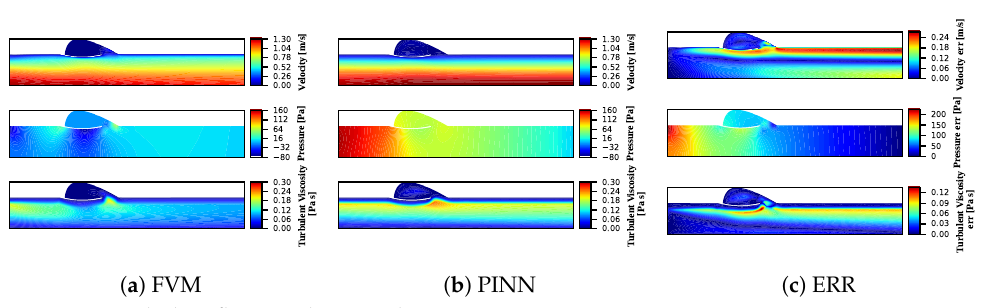
Figure A6. Turbulent flow: 75 degree